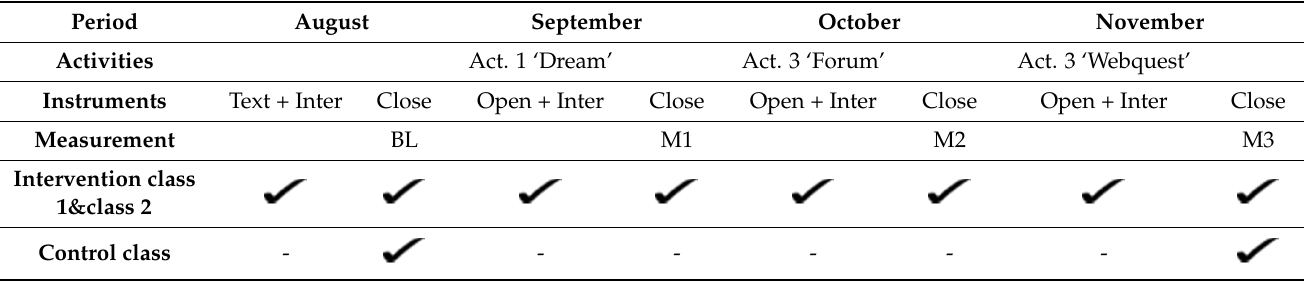
Table 2. Activities and measurements in intervention and control classes